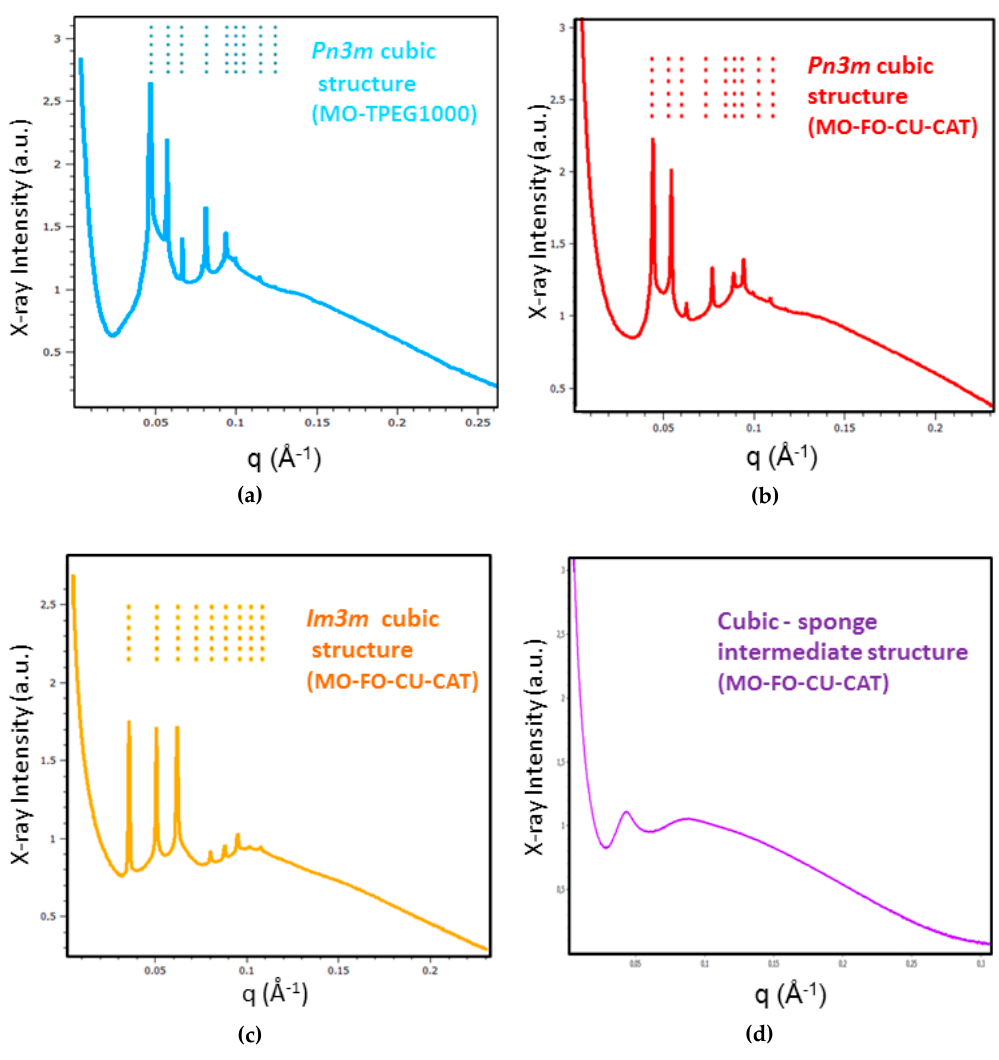
Figure 3. Representative BioSAXS patterns of MO / TPEG 1000 and MO / TPEG 1000 / FO / CU self-assembled mixtures hydrated in a phosphate buffer or in catalase (CAT) solutions at 22 °C. The recorded Bragg peaks are indicative of the formation of periodic liquid crystalline phases ( a – c ): ( a ) MO / TPEG 1000 lipid mixture hydrated in 0.01 M of phosphate buffer (pH 7.0): the sequence of dashed lines indexes from left to right the (110), (111), (200), (211), (220), (221), (310), (222) and (321) reflections of a diamond cubic lattice ( Pn3m space group); ( b ) MO / TPEG 1000 / FO / CU / CAT mixture: the dashed lines consecutively denote the (110), (111), (200), (211), (220), (221), (310), (222) and (321) reflections of a Pn3m cubic structure, which is preserved in the presence of encapsulated curcumin and catalase protein molecules; ( c ) Pattern of a MO / TPEG 1000 / FO / CU / CAT mixture with indexed (110), (200), (211), (220), (310), (222), (321), (400) and (330) reflections of a primitive cubic lattice ( Im3m space group); and ( d ) Pattern lacking well-defined Bragg reflections and corresponding to a cubic intermediate formed by the MO / TPEG 1000 / FO / CU / CAT mixture. The sample list is given in Section